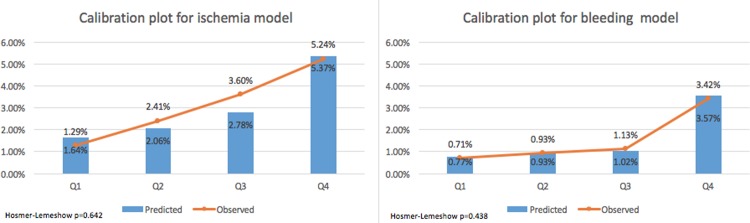
Calibration plots for the prediction models.Calibration plots of the ischaemia (left) and bleeding (right) prediction models, showing the predicted (blue bars) and observed (orange line and dots) rate of events stratified by the quartiles of the predicted risk.